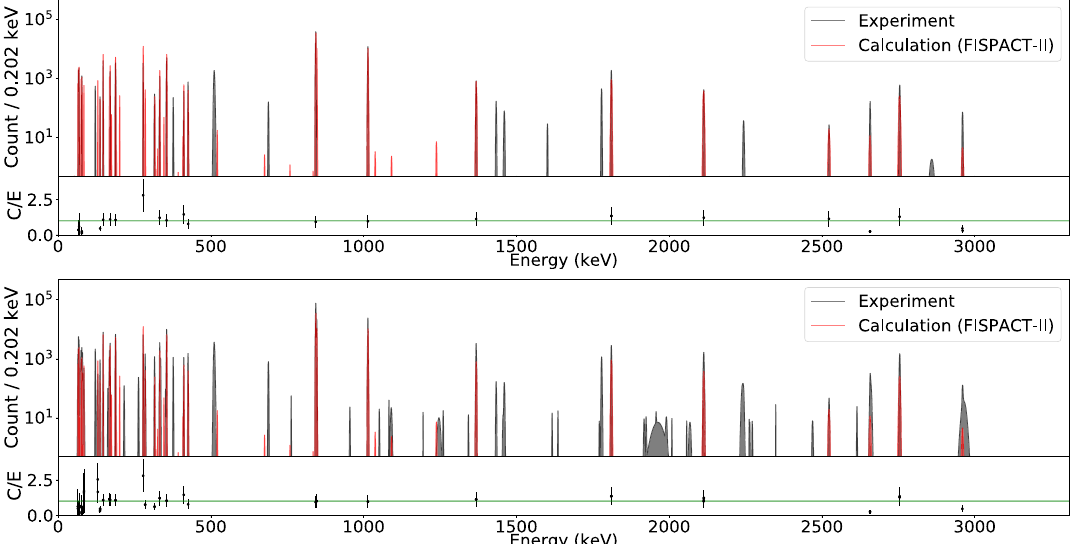
Figure 5: The comparison of FISPACT-II simulated gamma lines (red) to experimental gamma lines (black) following peak identification, background subtraction and Gaussian broadening using a sliding window approach (top) and a neural network (bottom) for peak identification, for the full energy range. C/E values are given below each